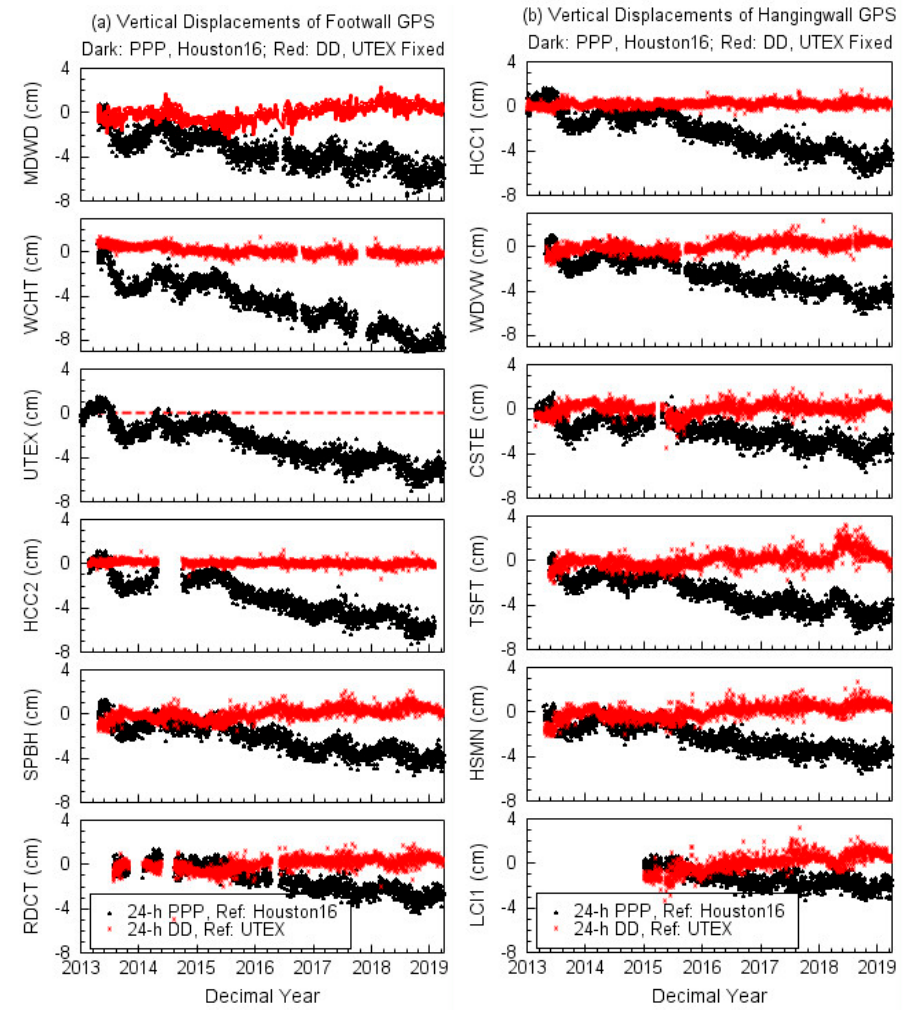
Figure 7. Plots depicting the data history and continuity of the Long Point GPS Array. The vertical displacement time series are derived from the 24-hour precise point positioning (PPP) solutions with respect to Houston16 and 24-hour carrier-phase double-difference (DD) solutions with respect to UTEX. The linear trends of the time series are listed in Table 1.